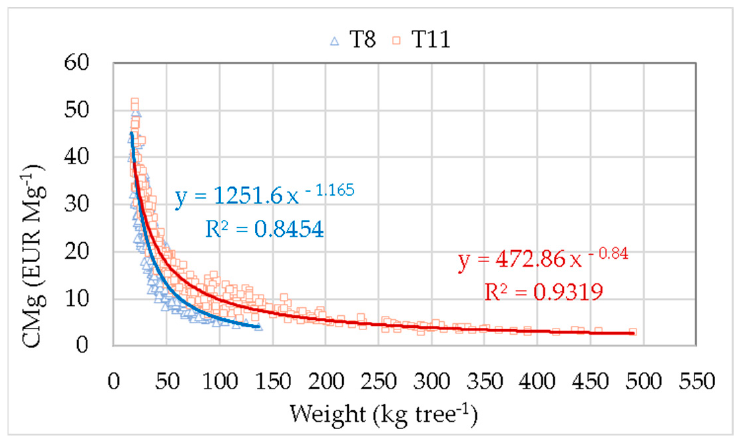
Figure 9. Estimation models of the unit cost ( CMg ) in relation to the weight of the tree for plantations T8 and T11.